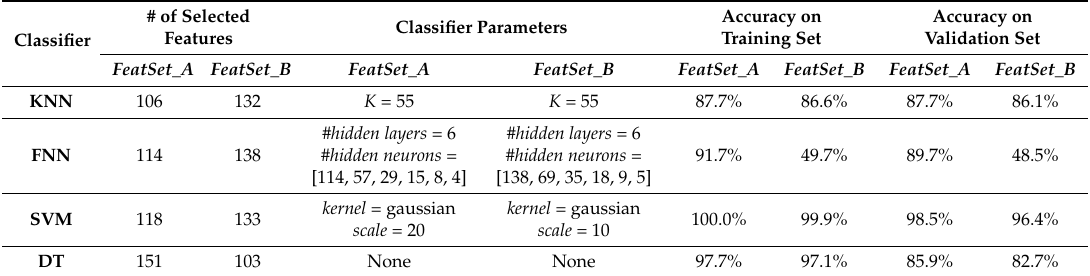
Table 1. GA results for each classifier and for the two feature